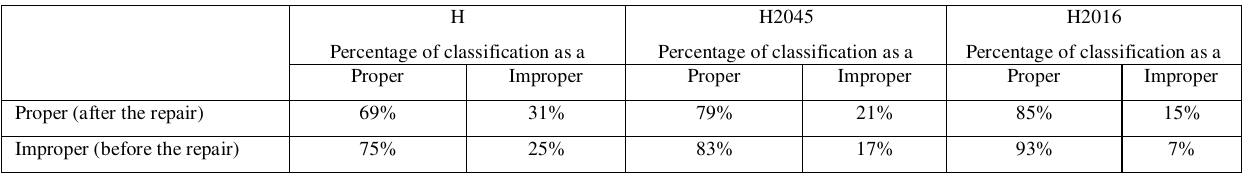
Table 5. The result of classification for data sets H – signals registered in horizontal transversal direction, H2045 – signals registered in horizontal trans- versal direction for locomotive 204 and H2016 – signals registered for horizontal transversal direction for locomotive